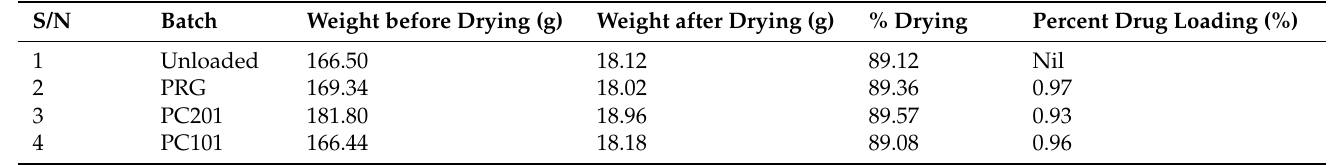
Table 2. Parameters related to drug loading and drying of the